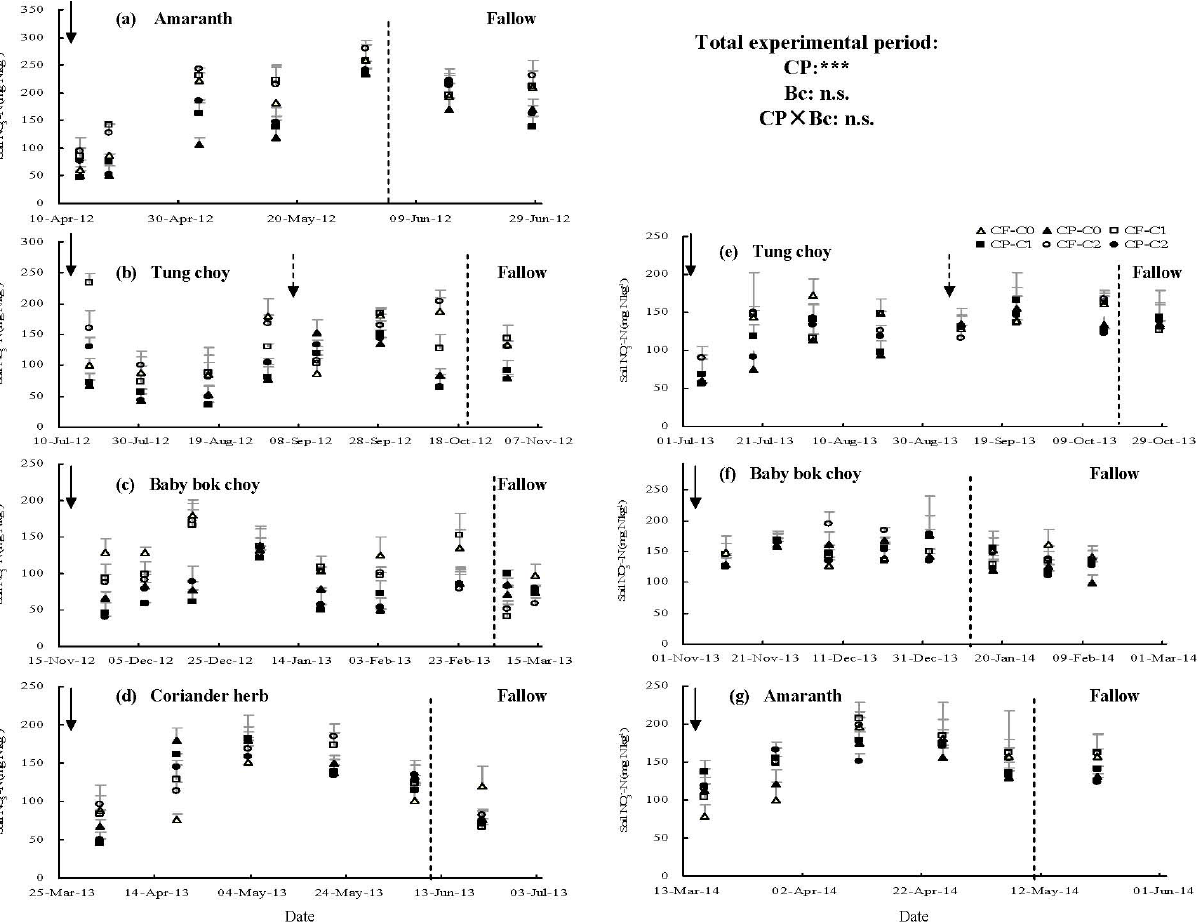
Figure 4. Dynamics of the soil NO − -N concentrations within the 0–15cm of soil under different treatments in vegetable fields with seven 3 consecutive vegetable crops from 2012 to 2014 in southeastern China. The solid and dashed arrows indicate basal fertilization and topdress- ing, respectively. The dashed vertical line in each subfigure separates different vegetable growth periods. The bars indicate the standard error of the mean ( + SE) for the three replicates of each treatment. See Table 2 for treatment codes. ∗∗∗ p < 0.001; n.s. – not